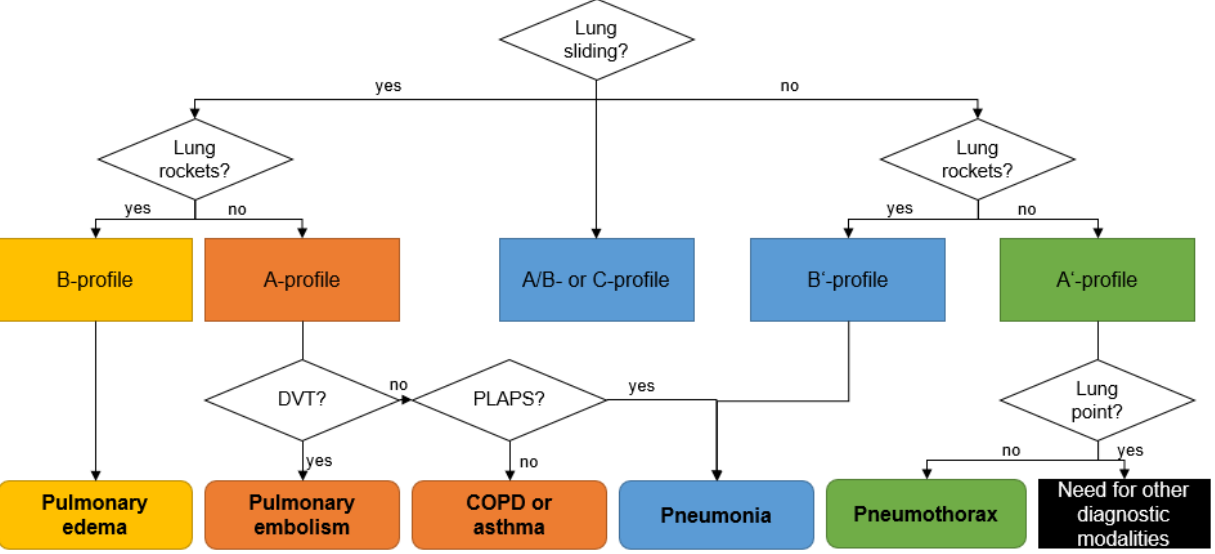
Figure 1. Sonographic decision tree according the BLUE-protocol. COPD: chronic obstructive pulmonary disease; PLAPS: posterolateral alveolar and/or pleural syndrome; DVT: deep venous thrombosis. Adapted from Lichtenstein et al. [30].